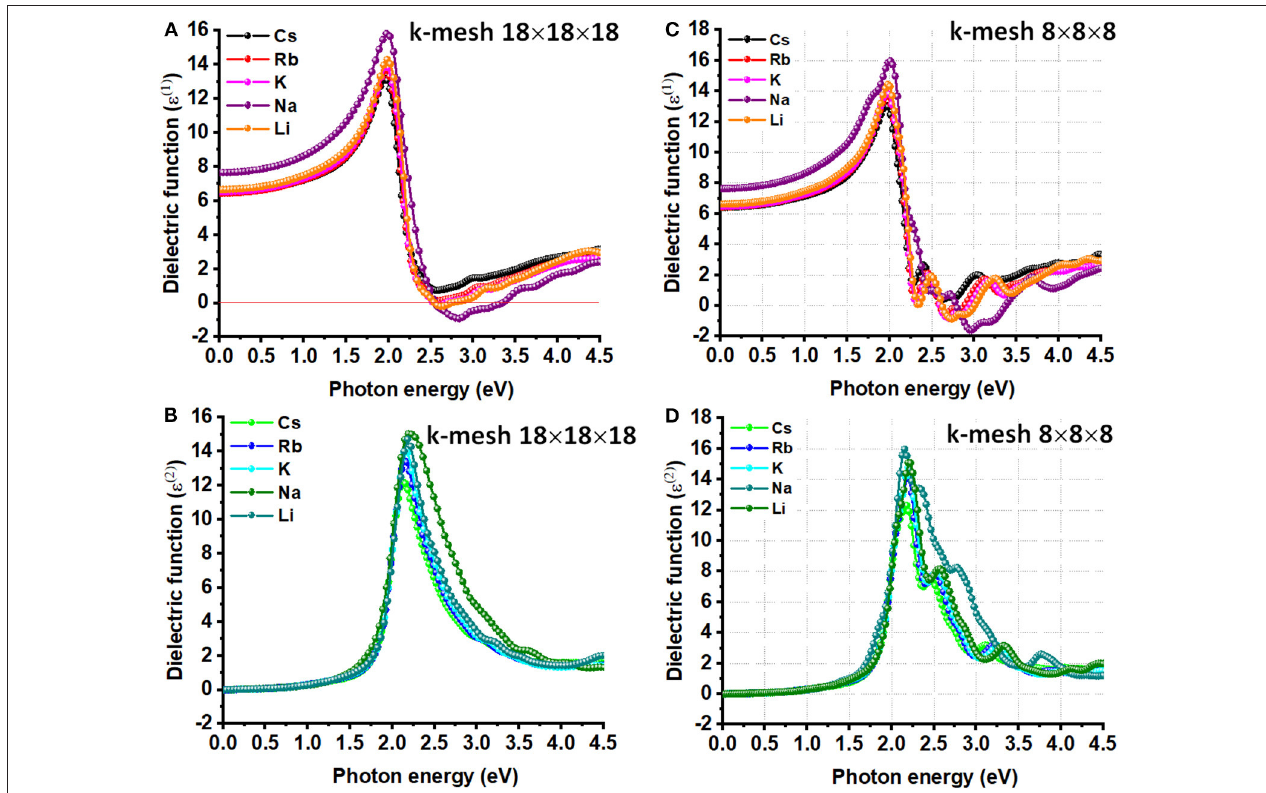
FIGURE 4 | The (A) real and (B) imaginary parts of dielectric function ε ( ω ) plotted against the photon energy for A 2 AgRhCl 6 (A DFPT/PBEsol. Shown in (C) and (D) are the corresponding plots obtained using k -mesh 8x8x8. The primitive cells used.